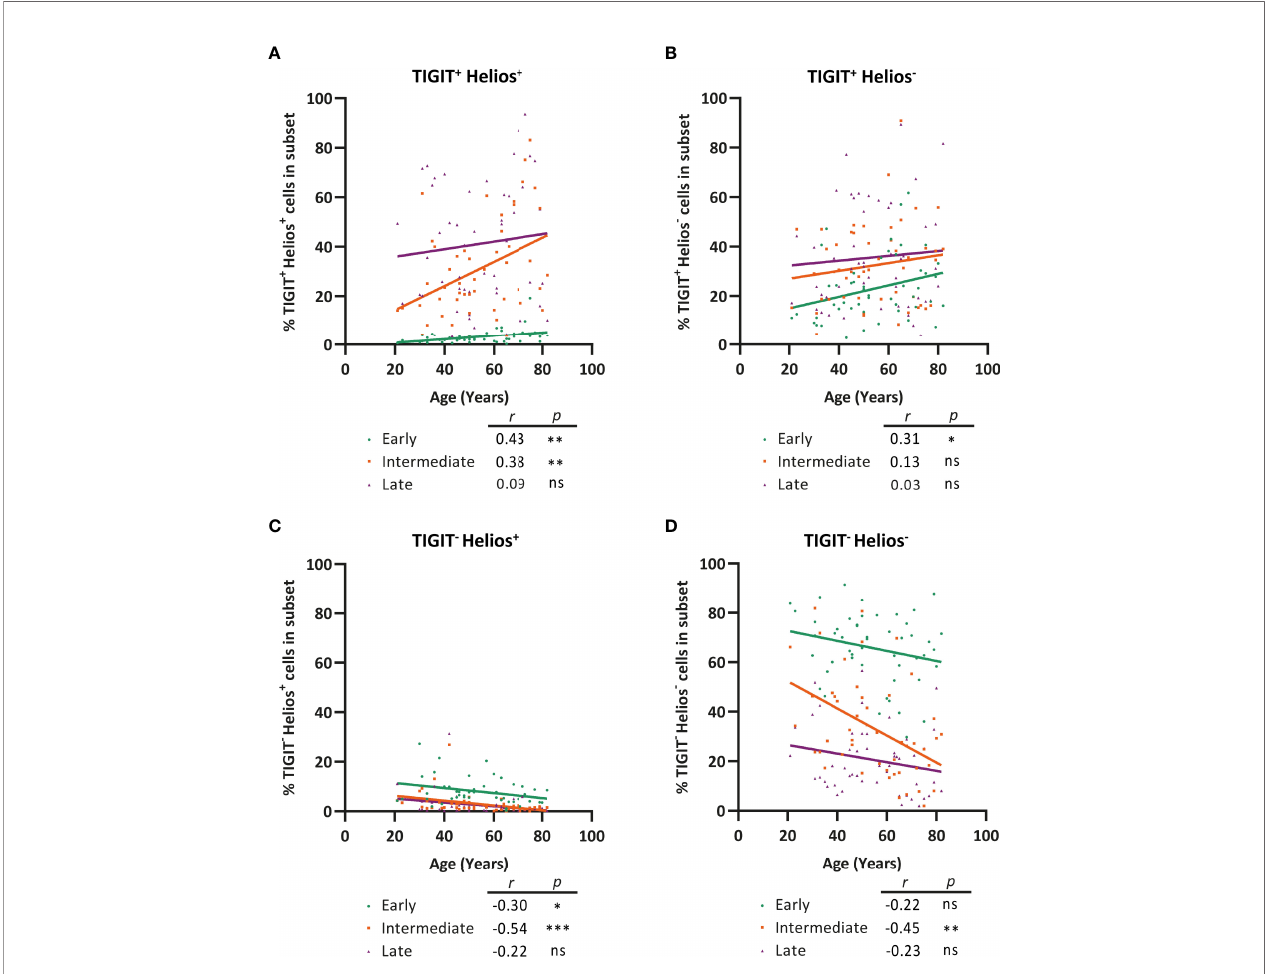
FIGURE 6 | Progression of CD8 + T-cell senescence (TIGIT + Helios + ) during aging occurs already in the intermediate phase of differentiation. Frequency of (A) TIGIT + Helios + , (B) TIGIT + Helios - , (C) TIGIT - Helios + , and (D) TIGIT - Helios - cells within the early-, intermediate-, and late-differentiated cell subsets and their relationship with age (n = 50). Correlations ( r and p values) were assessed by Spearman test with p < 0.05 considered as statistically signi fi cant. (* p < 0.05, ** p < 0.01, *** p < 0.001, ns, not signi fi